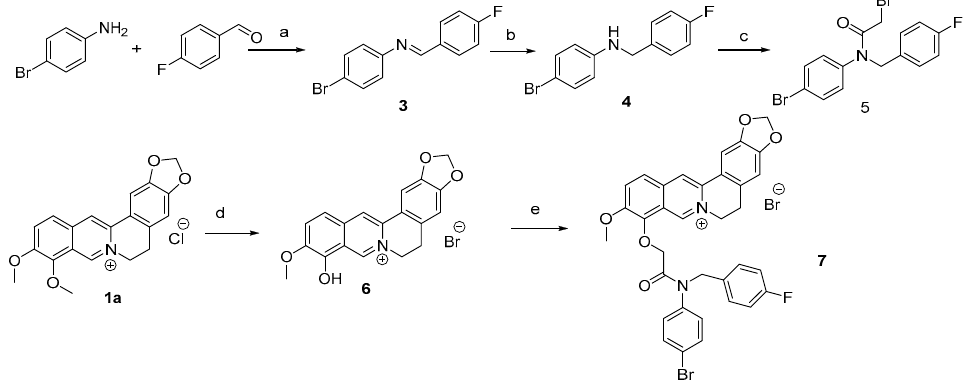
2 of 6 Figure 1. Structures of berberine and its derivatives with hypoglycemic activity. In this work, we have synthesized a new 9-O-derivative of berberine with a substitu- ent containing a fragment of a tertiary aromatic amide of acetic acid. The resulting com- pound was tested for hypoglycemic activity in an oral glucose tolerance test (OGTT) in mice. 2. Results 2.1. Chemistry A new 9-O-derivative of berberine with a substituent containing a fragment of a ter- tiary aromatic acetic amide was synthesized according to Scheme